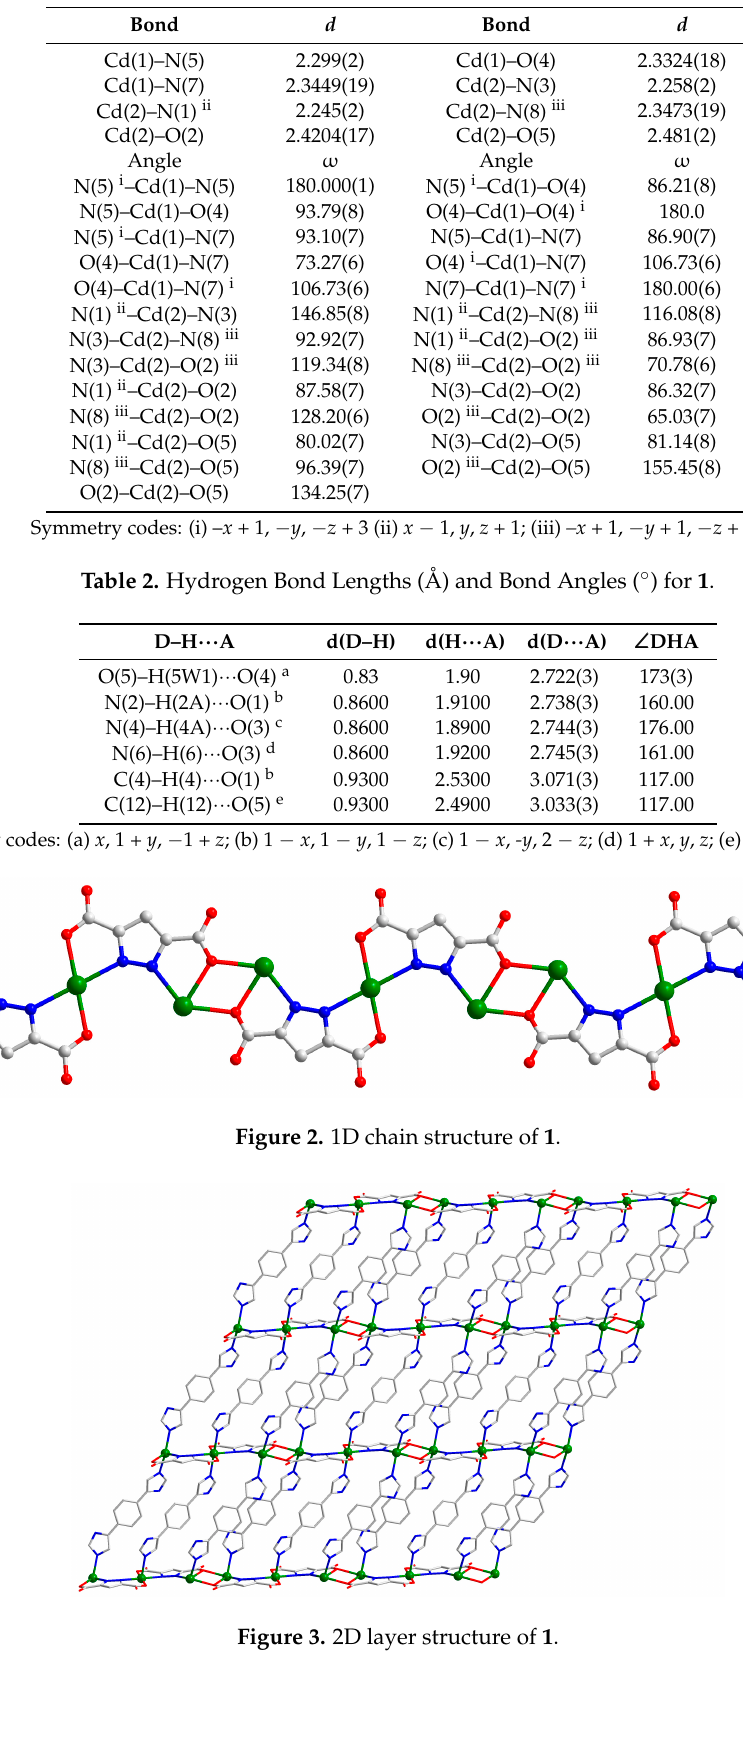
Table 1. Selected bond lengths (Å) and bond angles ( ◦ ) for 1 .